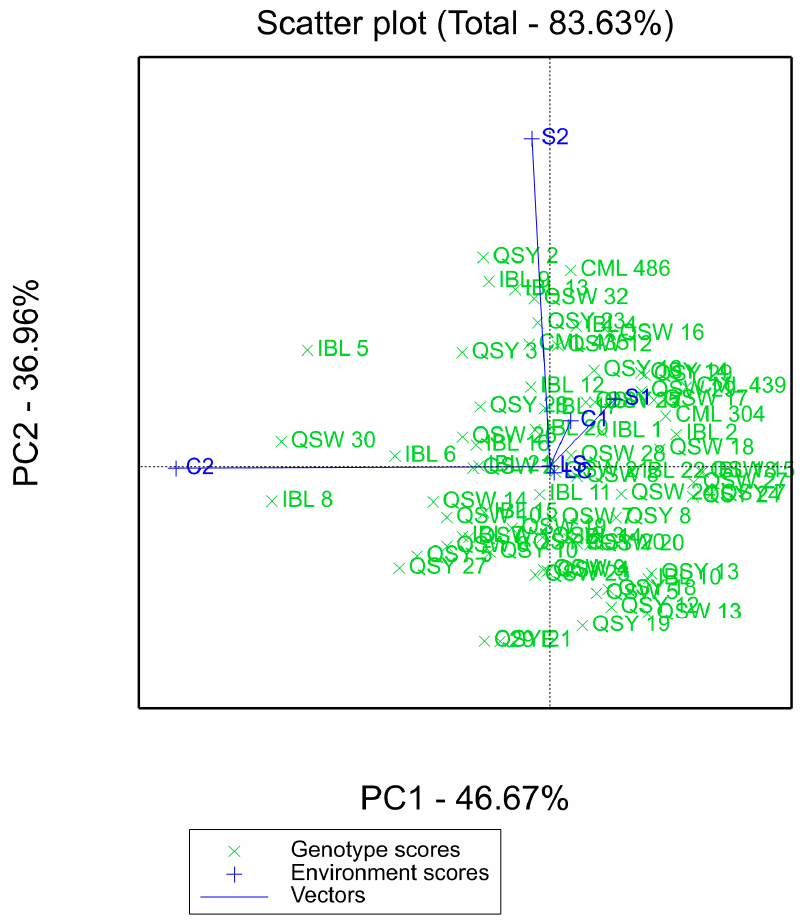
Figure 2. GGE biplot of the 75 QPM inbred lines evaluated across six laboratory and greenhouse